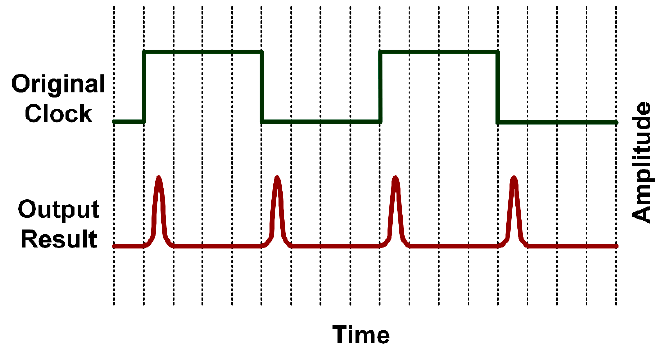
Figure 3. Relationship between pulse repetition frequency and initial clock frequency of low-voltage differential signaling (LVDS) oscillator.